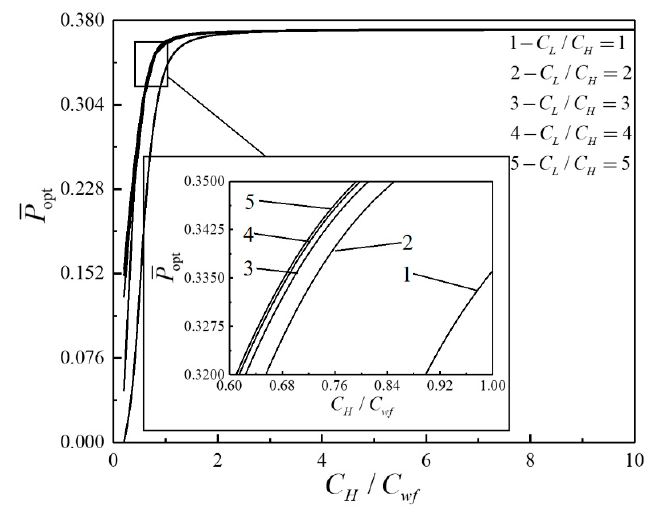
Figure 14. Relationship of P opt versus C H / C wf with di ff erent C L / C H .